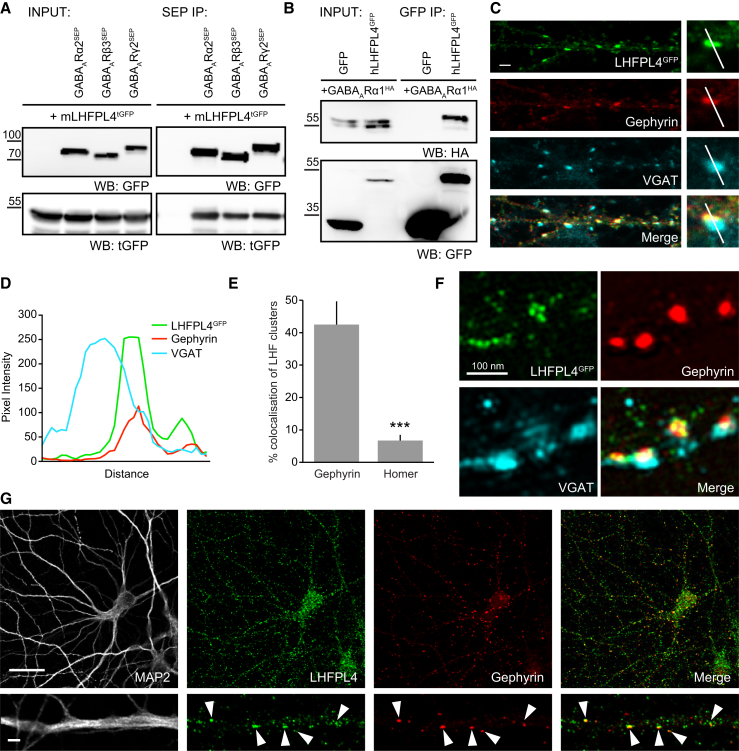
LHFPL4 Specifically Localizes to Inhibitory Synapses(A) Co-immunoprecipitation (coIP) of mouse LHFPL4-turboGFP (tGFP) with super-ecliptic-pHlourin (SEP)-tagged α2, β3, and γ2 GABAAR subunits from transfected COS7 cells (WB, western blot; IP, immunoprecipitation).(B) CoIP of human LHFPL4-GFP (hLHFPL4) with hemagglutinin (HA)-tagged GABAAR-α1 from transfected COS7 cells (WB, western blot; IP, immunoprecipitation).(C) Confocal images of dissociated rat hippocampal neurons transfected with LHFPL4GFP and labeled with antibodies against gephyrin and VGAT reveal a close association between LHFPL4GFP and gephyrin opposed to VGAT. Scale, 2 μm.(D) Graph shows a fluorescence intensity line scan through a synaptic cluster (white lines in C) for each channel as a function of distance.(E) Quantification of LHFPL4GFP clusters colocalized with gephyrin compared to homer puncta, generated from transfected hippocampal neurons and labeled with antibodies against gephyrin and homer (gephyrin: 42.5% ± 4.4%; homer: 6.7% ± 1.4%; n = 12 cells from 2 independent preparations; p < 0.001, Welch t test). Error bars indicate mean ± SEM. ∗∗∗p < 0.001.(F) Single-section SIM zoom images of hippocampal neurons transfected with LHFPL4GFP and labeled with antibodies against gephyrin and VGAT.(G) Confocal images of hippocampal neurons labeled with antibodies to endogenous LHFPL4, MAP2, and gephyrin reveal LHFPL4 overlaps with inhibitory synapses (white arrowheads). Scale, 20 μm (top) and 2 μm (bottom).See also Figure S1.